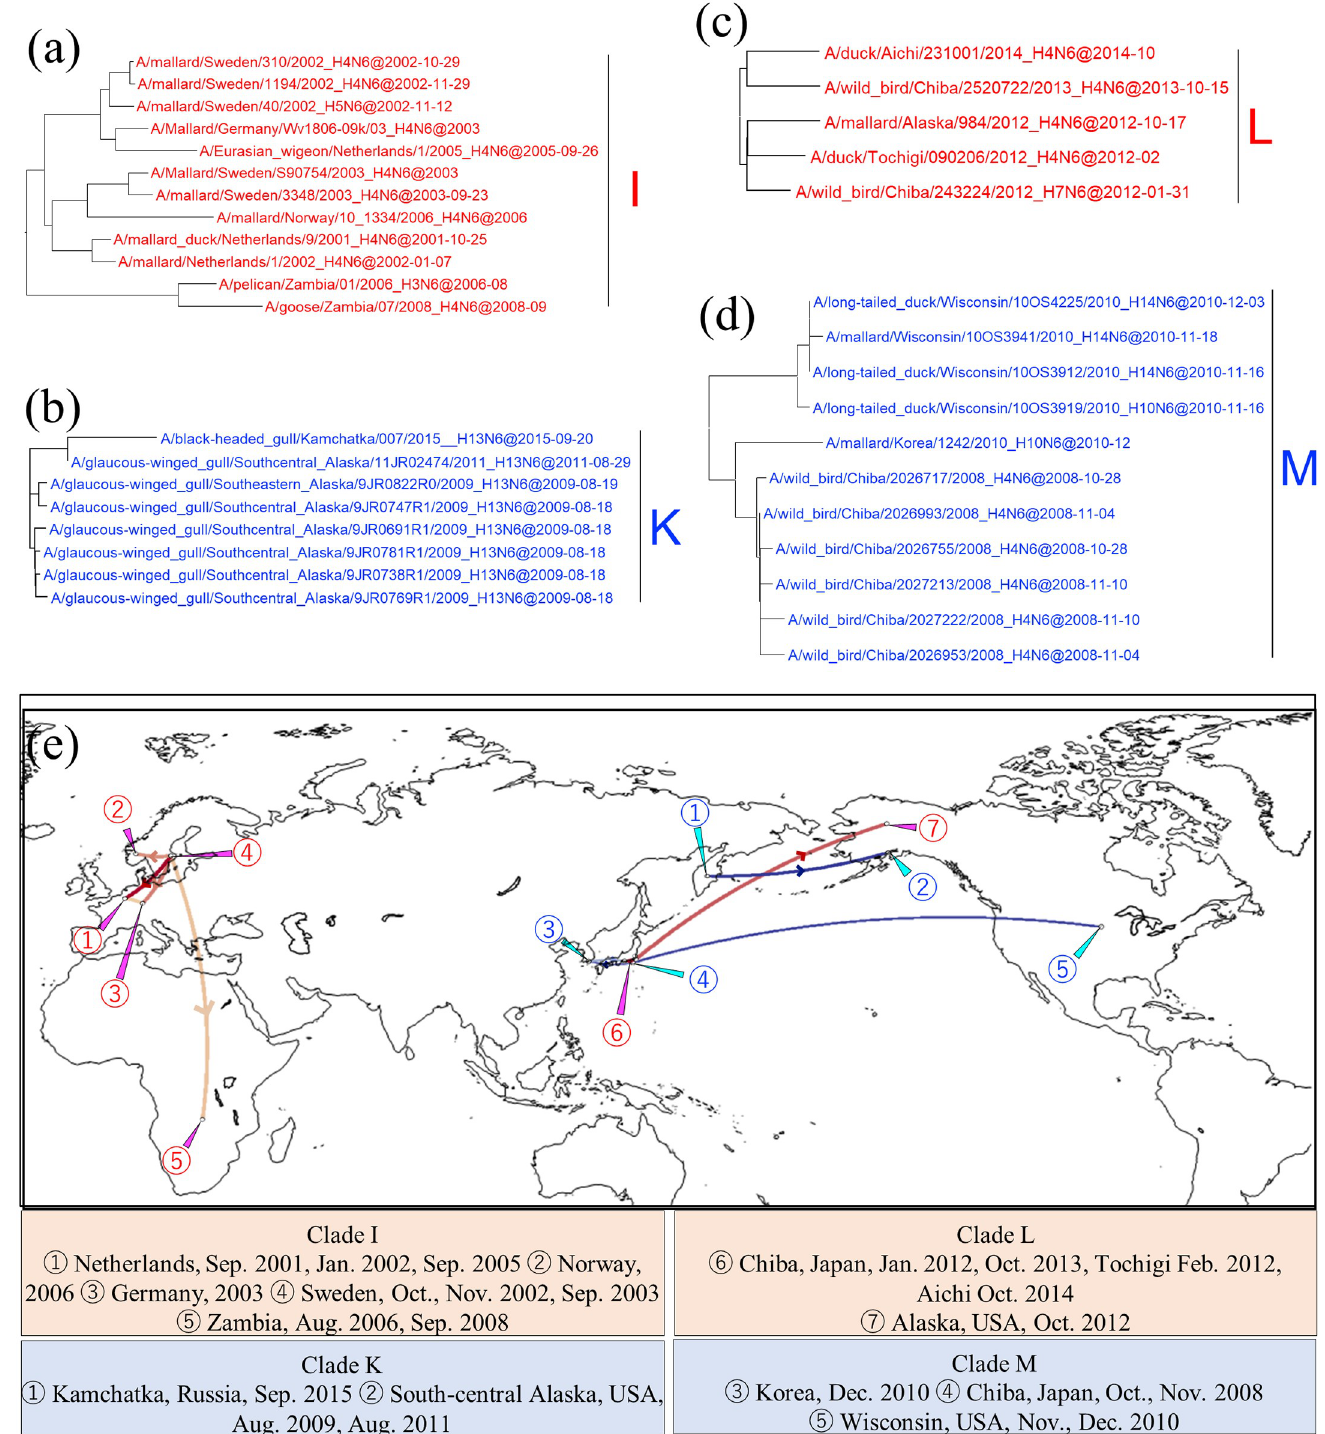
Fig 7. Detail of maximum clade credibility (MCC) phylogenetic trees of N6 NA genes in clades I, K, L, and M and visualized location-annotated MCC trees for selected clades on the world map (e). Clades I, K, L, and M are red type, blue type, red type, and blue type, respectively, in each tree (a, b, c, and d), and colored type lines in (e) correspond to those of the clades. Lines with Bayes factors of 3.0 or more are shown in the map, and a deeper color means a higher Bayes factor.